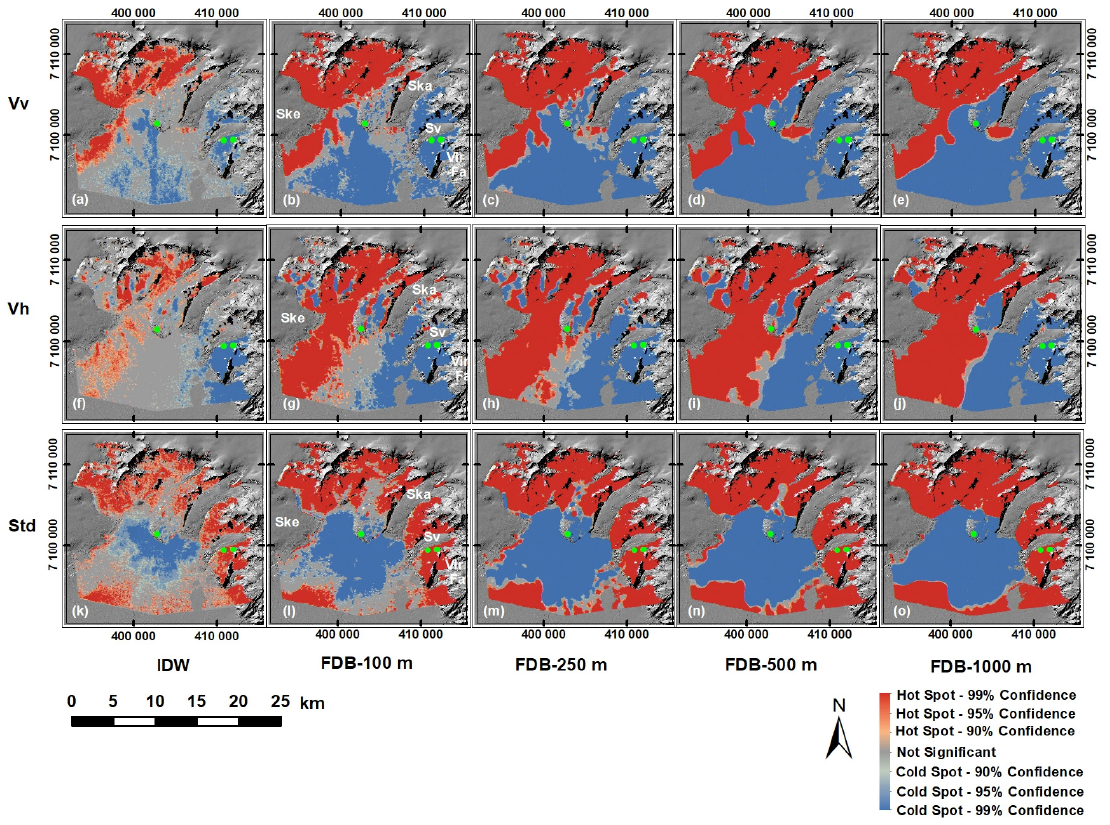
Figure 9. Hot Spots and Cold Spots identified based on two conceptual spatial relationships: Inverse Distance Weighted (IDW) and Fixed Distance Band (FDB). The IDW approach provides a smoother transition between “Hot Spot” (red), “Cold Spot” (blue), and “not significant” (grey) clusters than the FDB. Hot- and Cold-Spot clusters applying ( a , f , k ) IDW-100 m; ( b , g , l ) FDB-100 m; ( c , h , m ) FDB-250 m; ( d , i , n ) FDB-500 m; and ( e , j , o ) FDB-1000 m, for parameters V v , V h and std . V los , respectively. When the FDB increases, the probability that a PS will be classified as Hot Spot (high value) or Cold Spot (low value) also increases, resulting in more homogenous clusters, as well as the gradual disappearance of insignificant clusters. The significant Hot-Spot and Cold-Spot clusters in ( b , g , l ) (FDB = 100 m) spatially outline the highly dynamic QPSs, implying that areas undergo extreme surface-deformation processes.